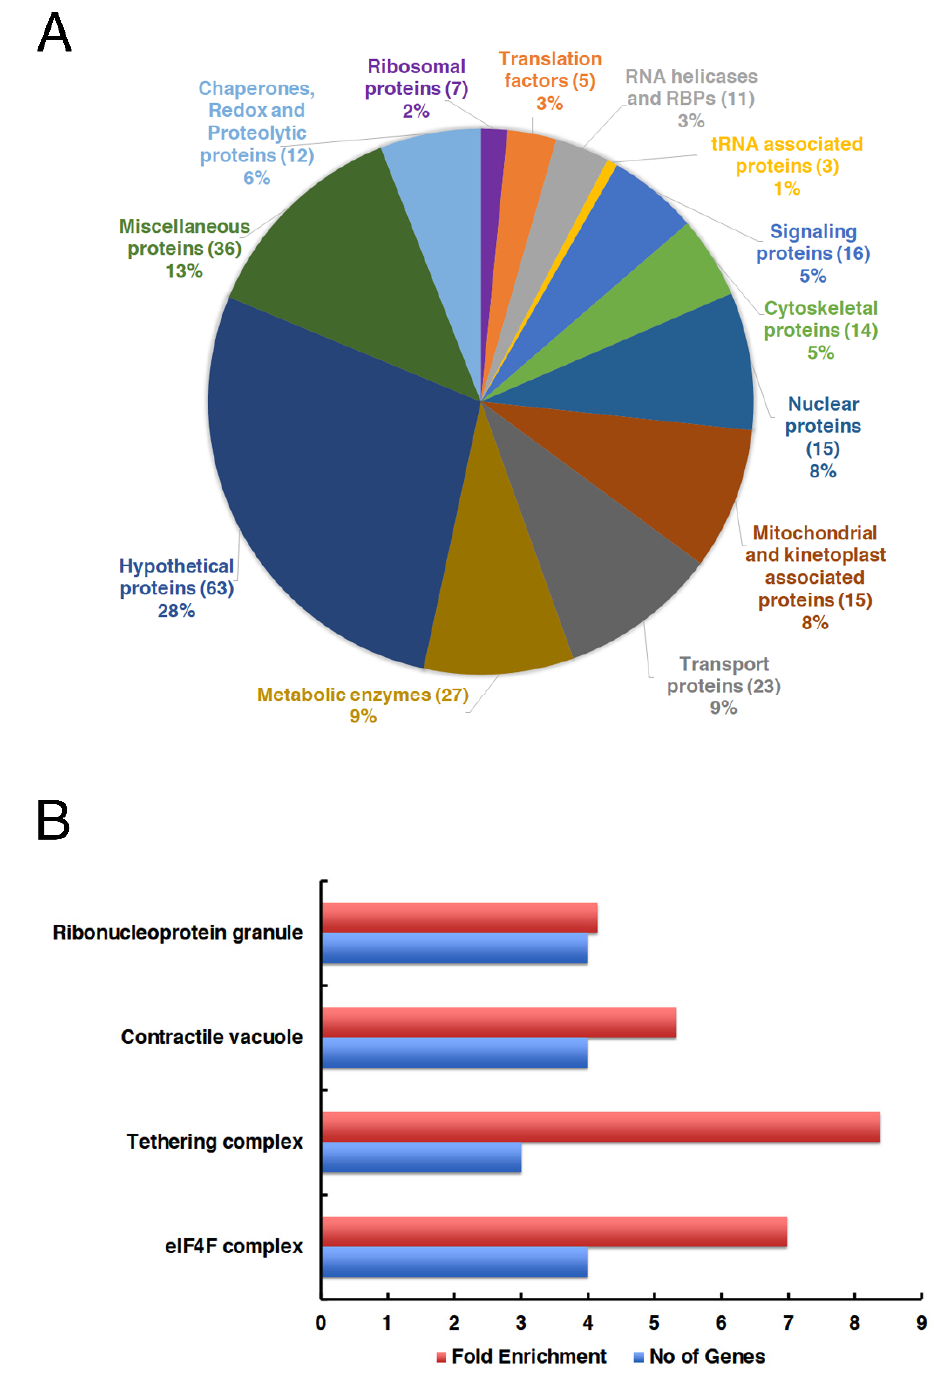
Figure 5. The proteomic content of LeishIF4E-6 associated proteins. Extracts of the cells overexpress- ing SBP-tagged LeishIF4E-6 were purified over streptavidin beads, washed and eluted with biotin. The eluted proteins were subjected to LC-MS/MS analysis. MaxQuant software was used to identify the detected proteins. Luciferase overexpressing cells were used as a negative control to subtract the background proteins. Perseus statistical tool was used to set a cut-off value of 1.6 Log 2 fold (three- fold change) and a p -value < 0.05. ( A ) The pie chart represents the manually categorized clusters of proteins that were enriched in the LeishIF4E-6 associated fraction, as compared to the luciferase control. ( B ) Proteins that were enriched in the LeishIF4E-6 associated fraction were subjected to the Gene Ontology enrichment tool in TryTripDB based on cellular components. The threshold value for GO term was set to 4-fold with p -value < 0.01.